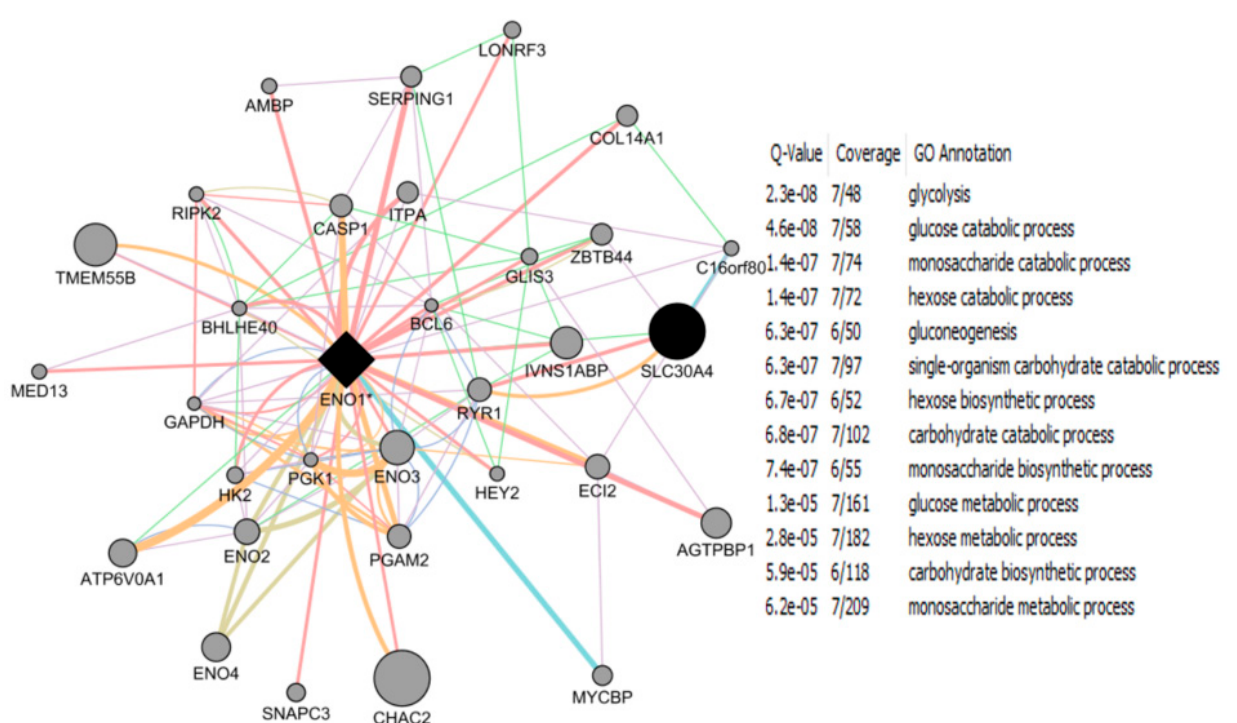
Figure 9. Gene set pathway enrichment analysis of cadmium responsive E2 and NRF1 common target genes associated with Alzheimer’s Disease (AD). The network includes the top 30 Cd related genes in AD in gray. Cadmium responsive NRF1 genes are in black. Genes denoted by a diamond-shaped node and * are E2 and NRF1 responsive. The network includes the top 30 related genes in gray. Right panel show GO annotations of E2 and NRF1 enrichment network genes of cadmium associated with biological process pathways involving multiple E2 and NRF1 genes and Q -value as a probability showing number of genes out of the total genes annotated to each GO term.